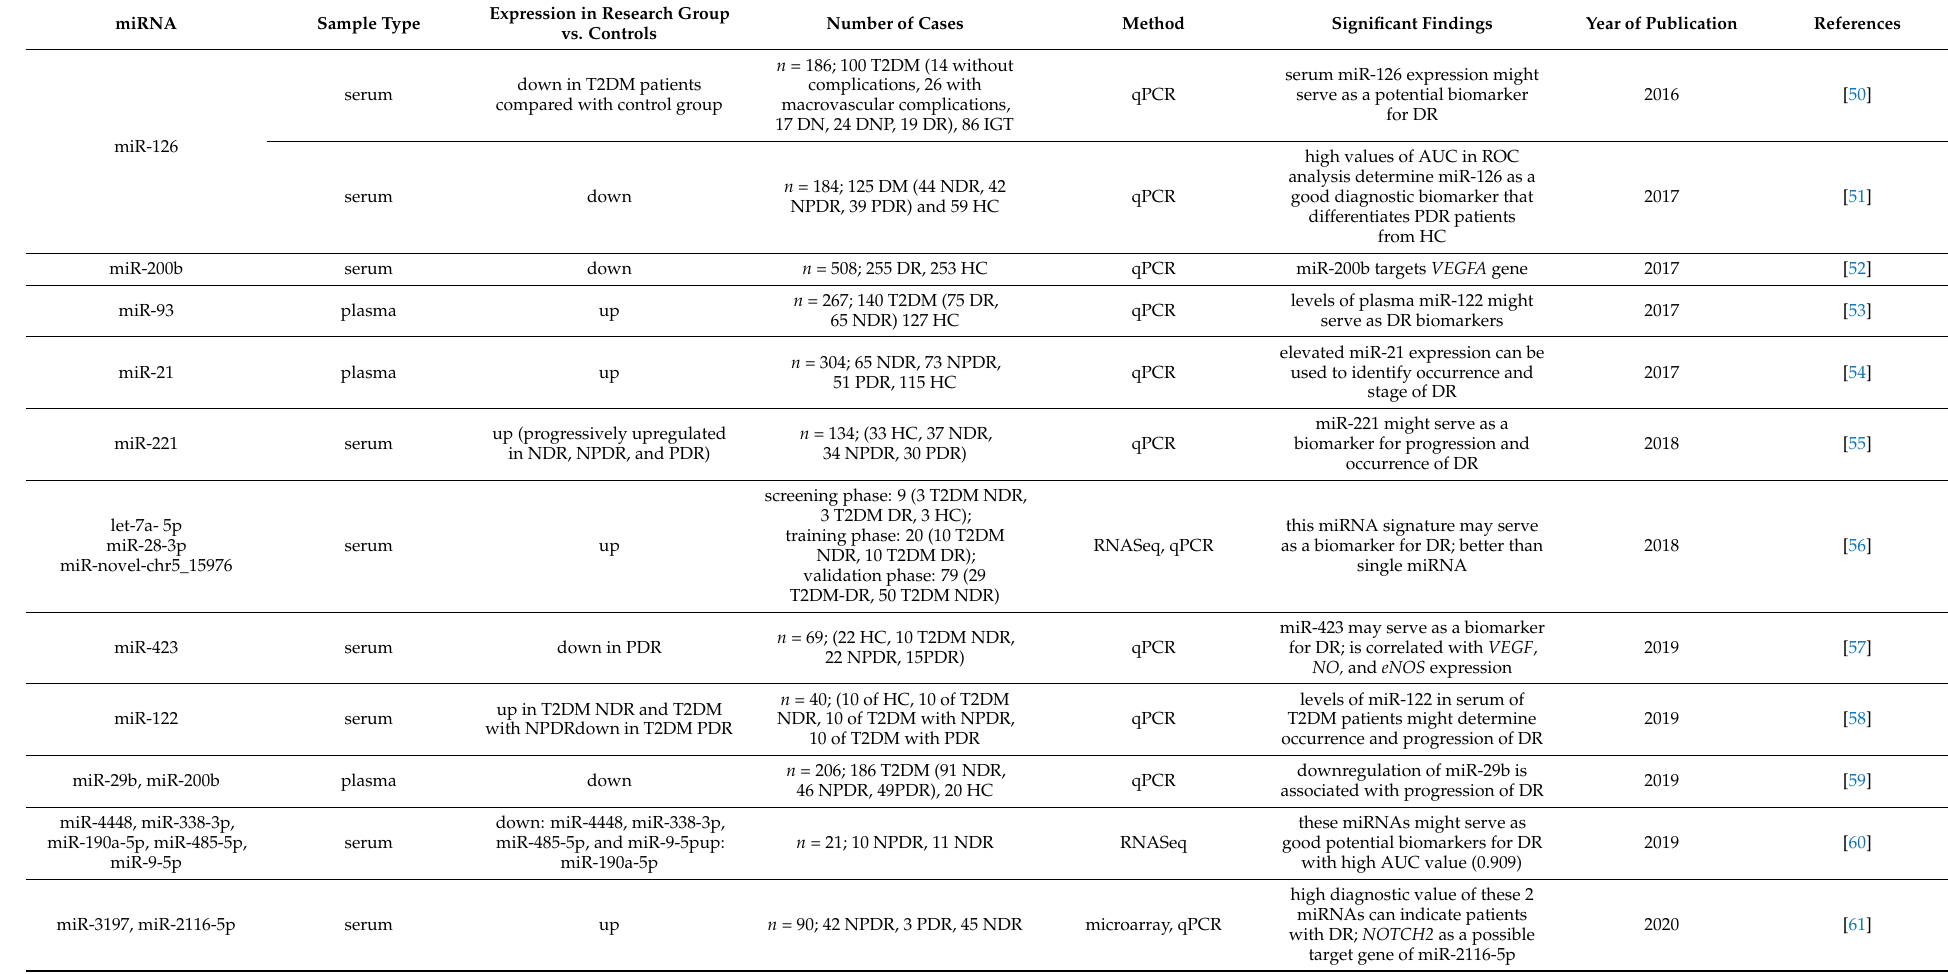
Table 2. Latest reports concerning miRNAs in biofluids of human patients with